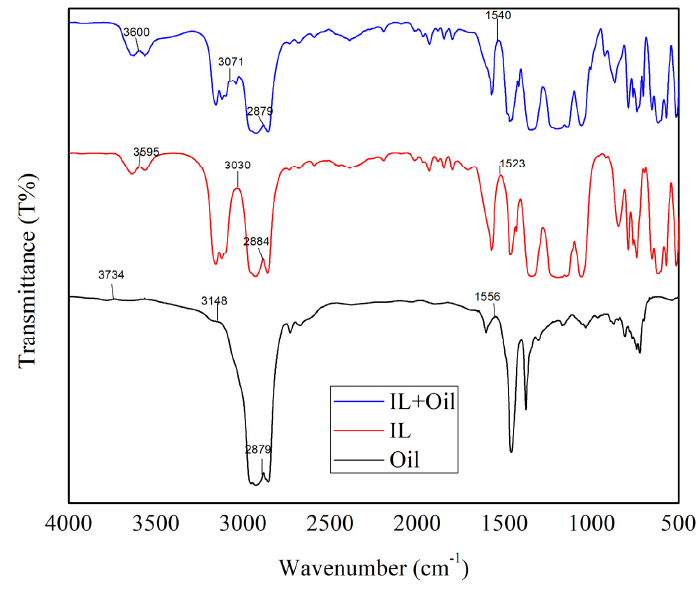
Figure 6. FTIR spectra of IL4 before and after extraction of oil from produced water and oil alone.